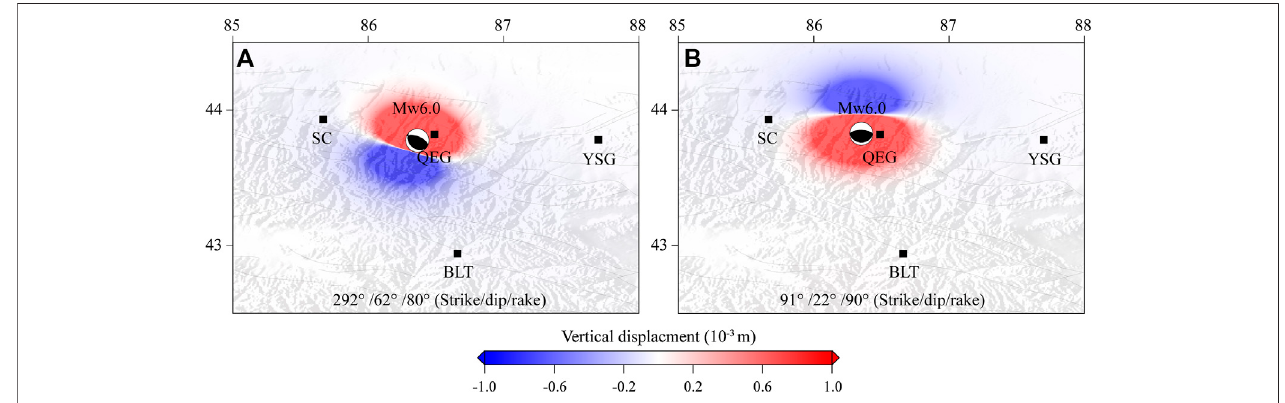
FIGURE 5 | Vertical coseismic displacement fi eld for different sets of source parameters. The red line in the beach ball denotes the fault plane.